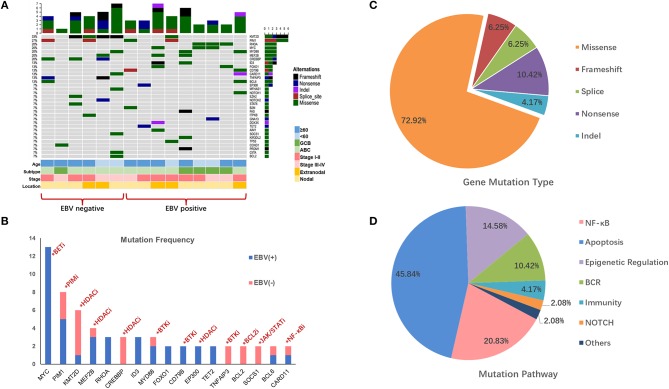
Mutation profile in EBV+ and EBV- negative DLBCL groups. (A) The distribution and frequency of genetic alterations in nine EBV+ DLBCL and six EBV- negative DLBCL. The types of mutation and different clinical factors are labeled in different colors. (B) Gene mutation with potential targeted therapy. The frequent mutation genes in EBV+ and EBV- negative DLBCL cohorts and the potential targets highlighted by indicating the possible targeted therapy. (C) Pie chart showing the percentages of different types of somatic mutation in EBV+ DLBCL. (D) Mutation pathway distribution among EBV+ DLBCL specimens. Different color represents diverse mutation pathways and percentages.